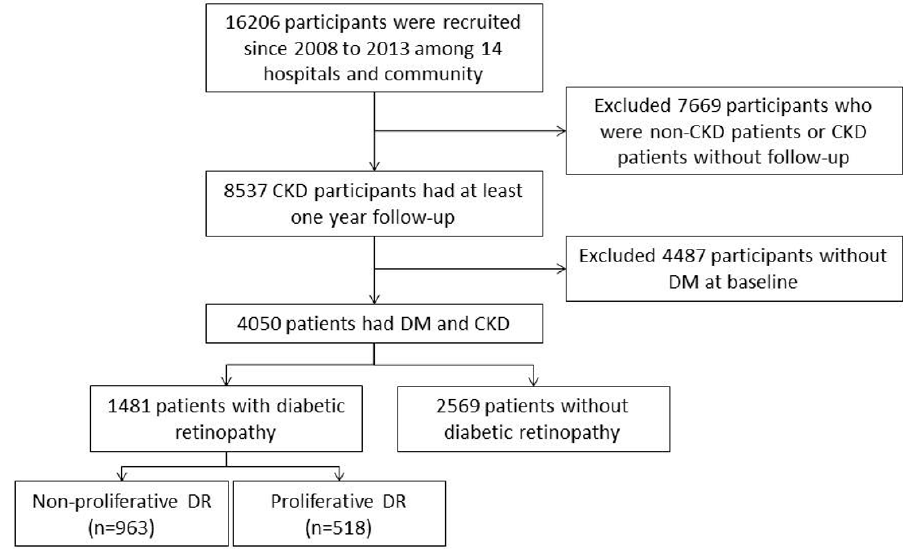
Figure 1. Recruitment process flow chart. The chronic kidney disease (CKD) cases were recruited from the nephrology outpatient clinics in each hospital and from the community. DM, diabetes mellitus; DR, diabetic retinopathy.